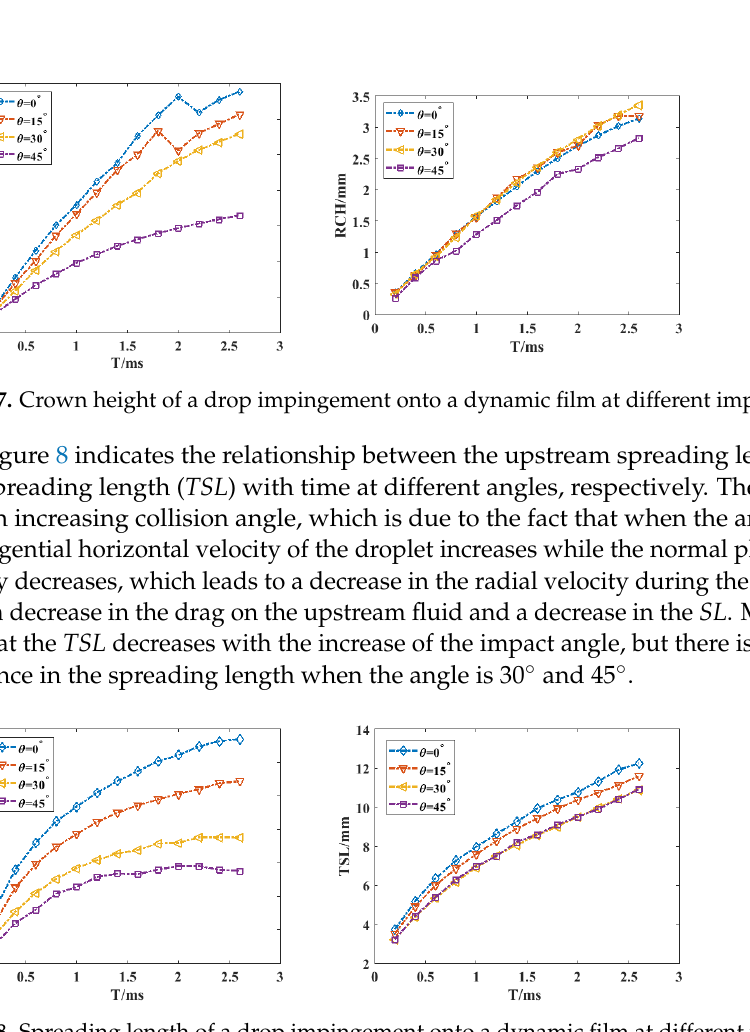
Figure 8. Spreading length of a drop impingement onto a dynamic film at different impact